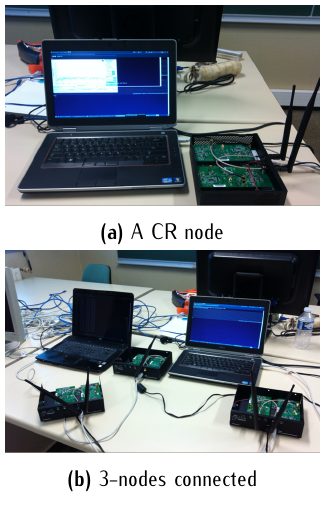
Figure 8. Cognitive Radio